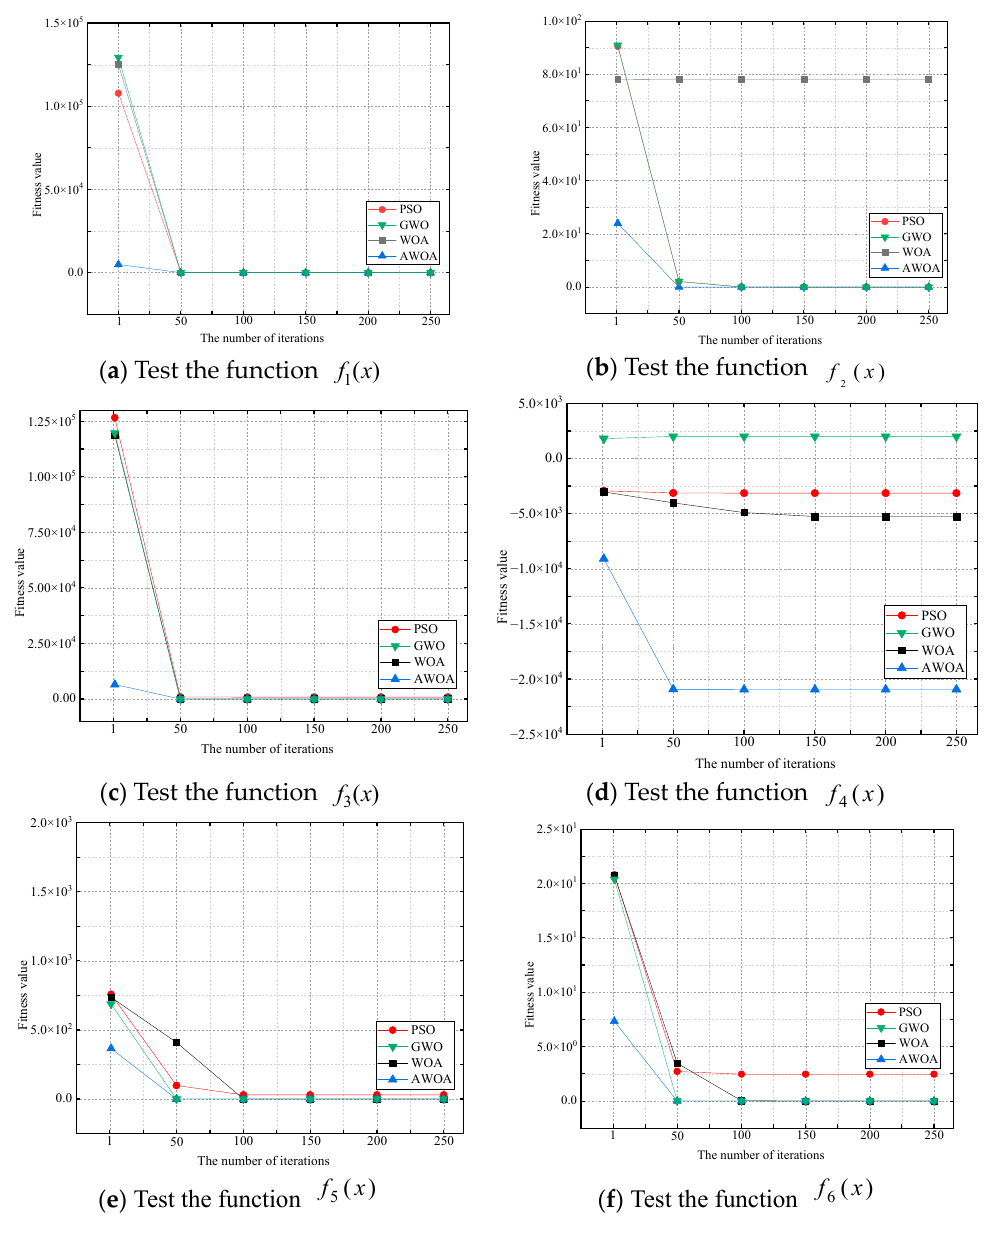
Figure 5. Comparison of AWOA with other algorithms.